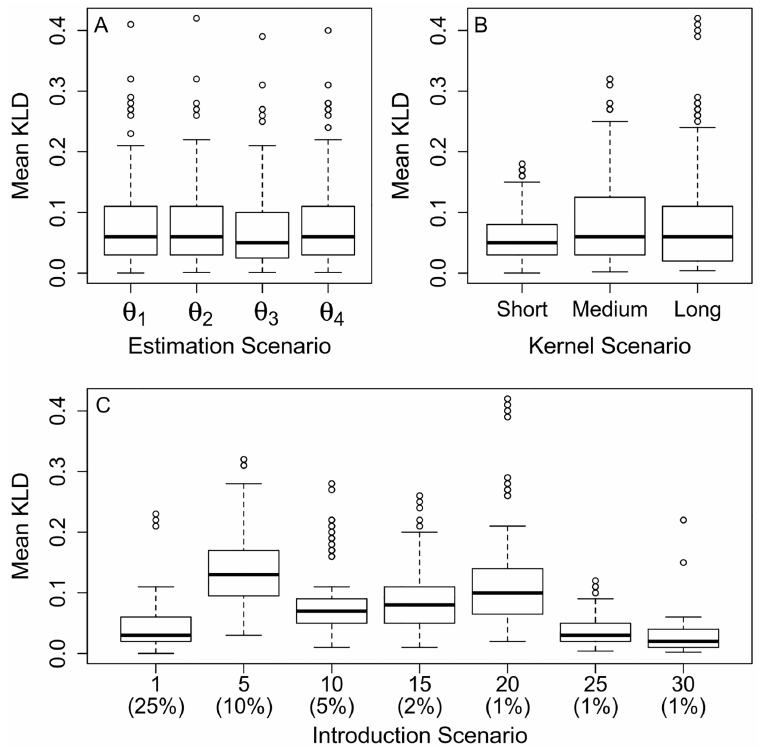
Fig 3. Boxplots of distances between simulated and estimated dispersal kernels. Impact of (A) estimation scenario, (B) kernel range, and (C) disease introduction scenario [number of introduction patches (with initial disease prevalence)] on the accuracy of estimated dispersal kernels. Accuracy is measured by the Kullback-Leibler distance (KLD) between simulated and estimated dispersal kernels. Each panel consists of 840 points, which correspond to 10